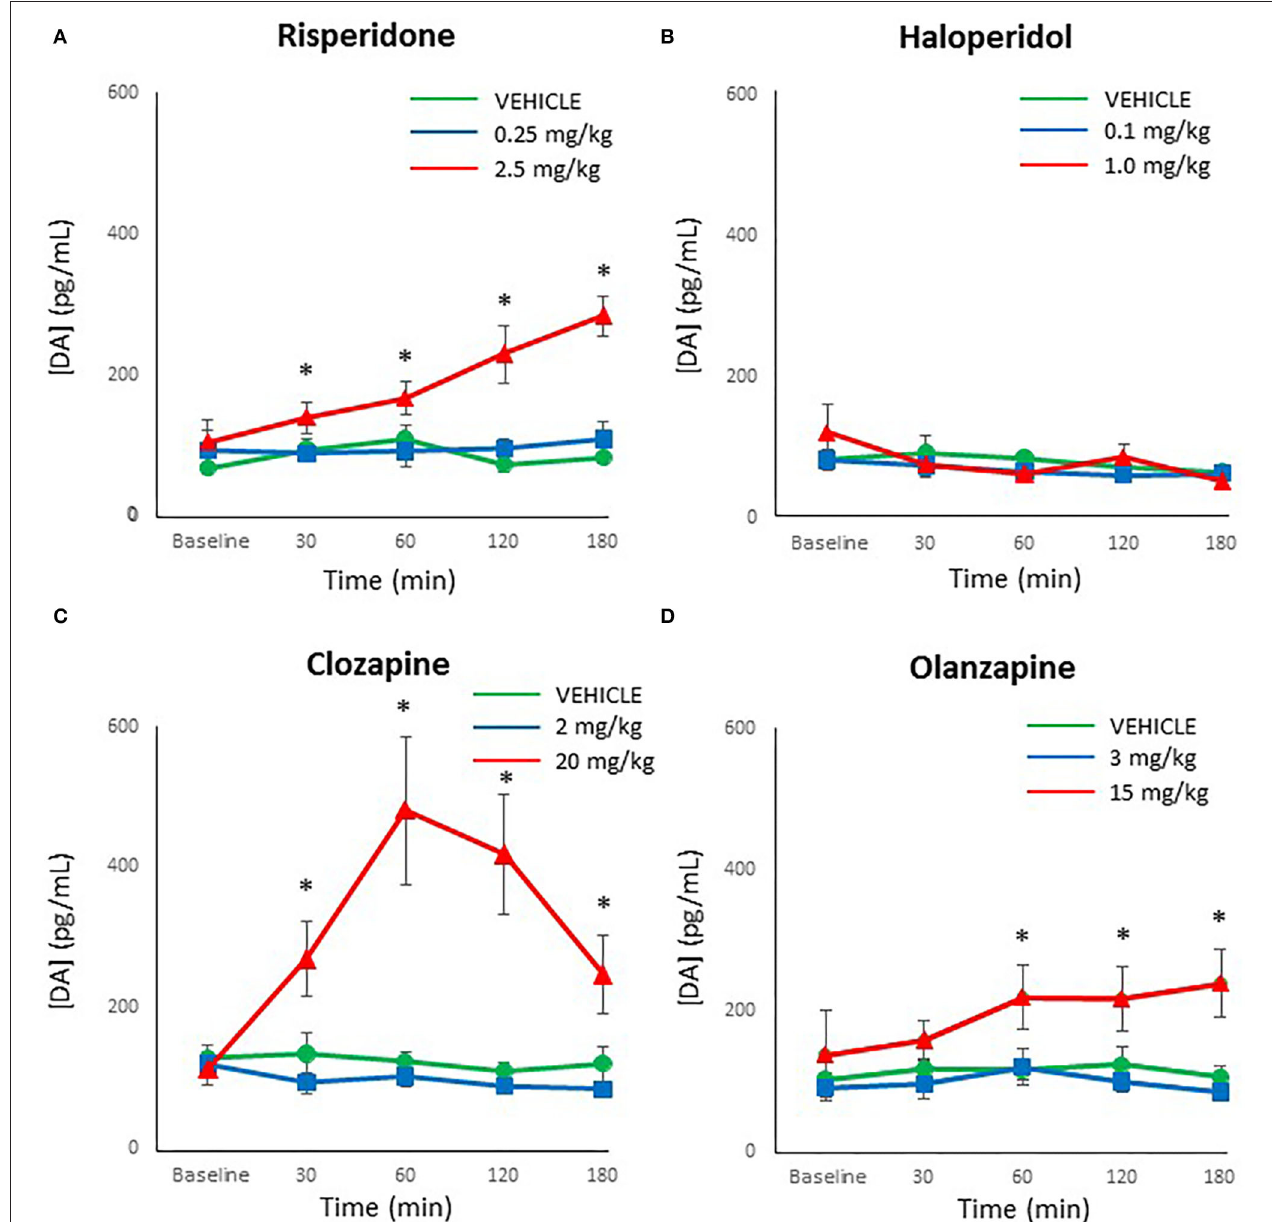
FIGURE 4 | Acute changes in plasma dopamine (DA) concentrations (pg/ml) after antipsychotic drug treatment in adult female rats. Animals ( n = 10 per group) were given a single IP injection of (A) risperidone (0.25 or 2.5 mg/kg) or (B) haloperidol (0.1 or 1.0 mg/kg) or (C) clozapine (2 or 20 mg/kg) or (D) olanzapine (3 or 15 mg/kg) or vehicle. Values are expressed in group means ± SEM. Plasma samples were collected immediately prior to drug treatment (Baseline) and at 30, 60, 120, and 180mins after treatment. * Statistically significant difference between high dose group and both other groups, p <